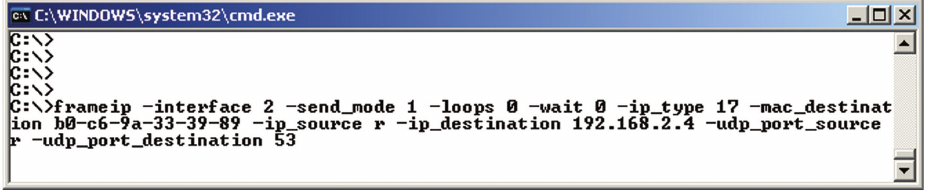
Figure 11. Frameip’s Online Command for Generating UDP Flood